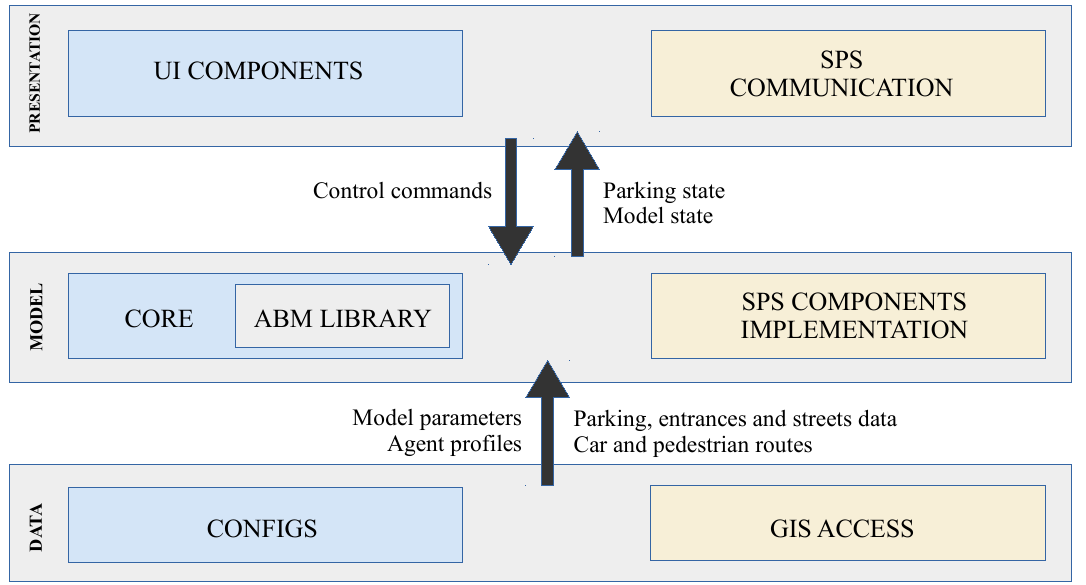
Figure 1. Simulator’s layered organization. SPS = smart parking systems; GIS = Geographic Information Systems; ABM = Agent-Based